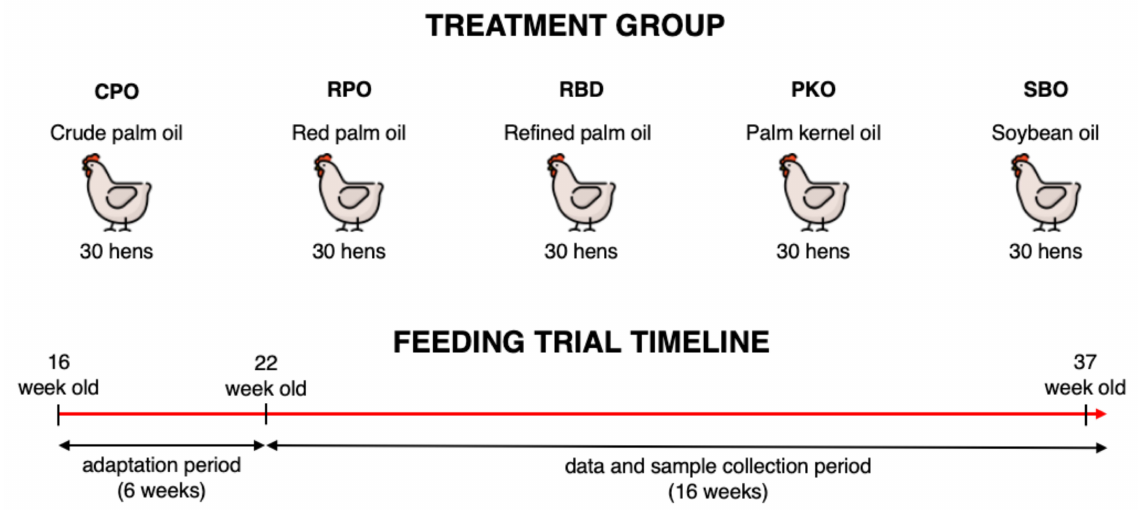
Figure 2. Experimental design and feeding trial